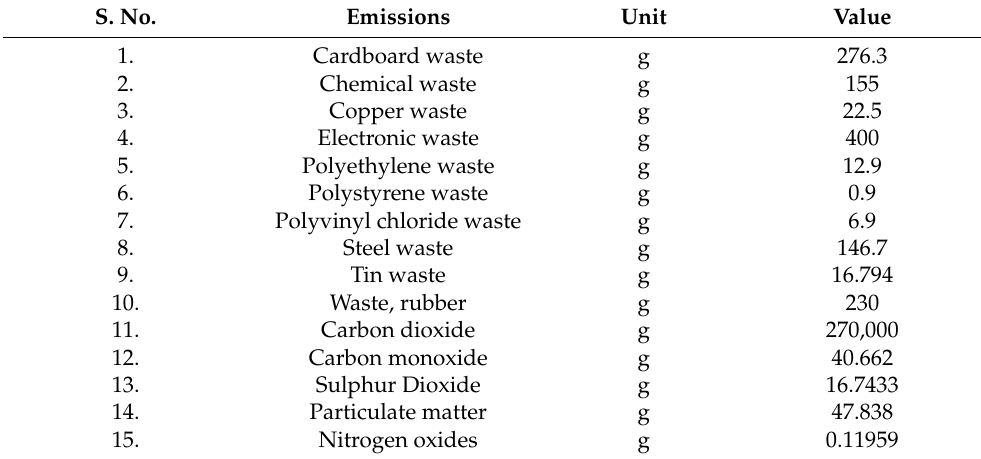
Table 3. List of remanufacturing outputs for LCA.